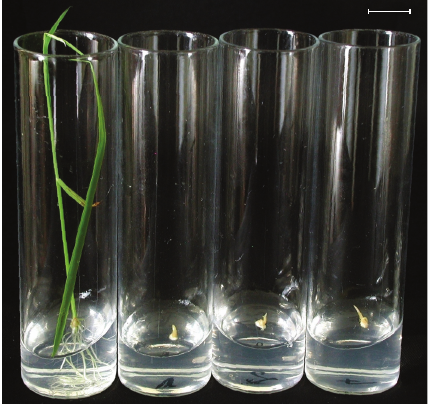
Figure 1: Germination of mature embryos of the nontransgenic spring wheat variety CY-45 on media containing 0, 1, 2, and 4mg · L − 1 glufosinate ammonium (from left to right) on the tenth day of culture. bar ∗ 1.0 cm.